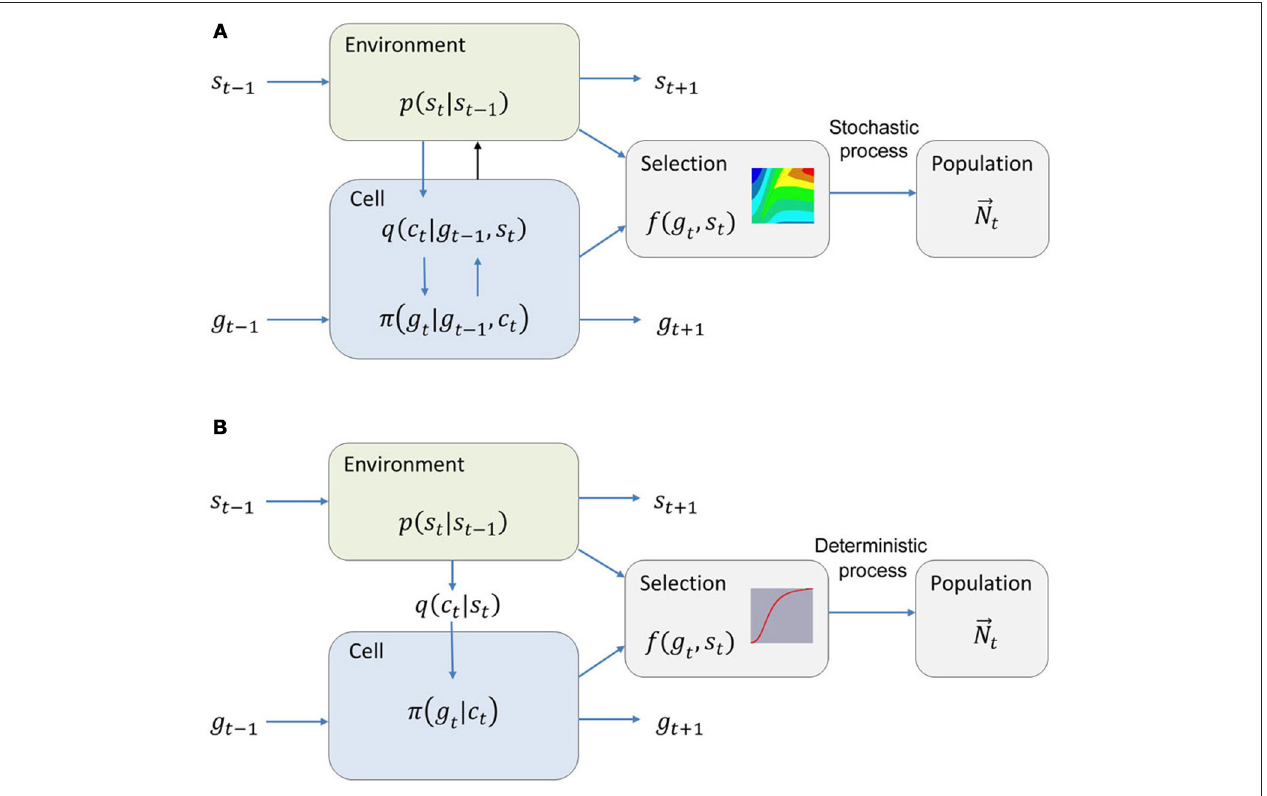
FIGURE 4 | Schema of the models for a cell’s response to changing environments. (A) Full model as described in the text. Note the black arrow, which represents the possibility that the cells will change their environment. (B) In the simplified system, all cells receive the same information from the environment, independently of their state. Cells have no memory, the instantaneous fitness is a multiplication factor rather than a probability and it is 0 except for one phenotypic state per environment. Based on Rivoire and Leibler